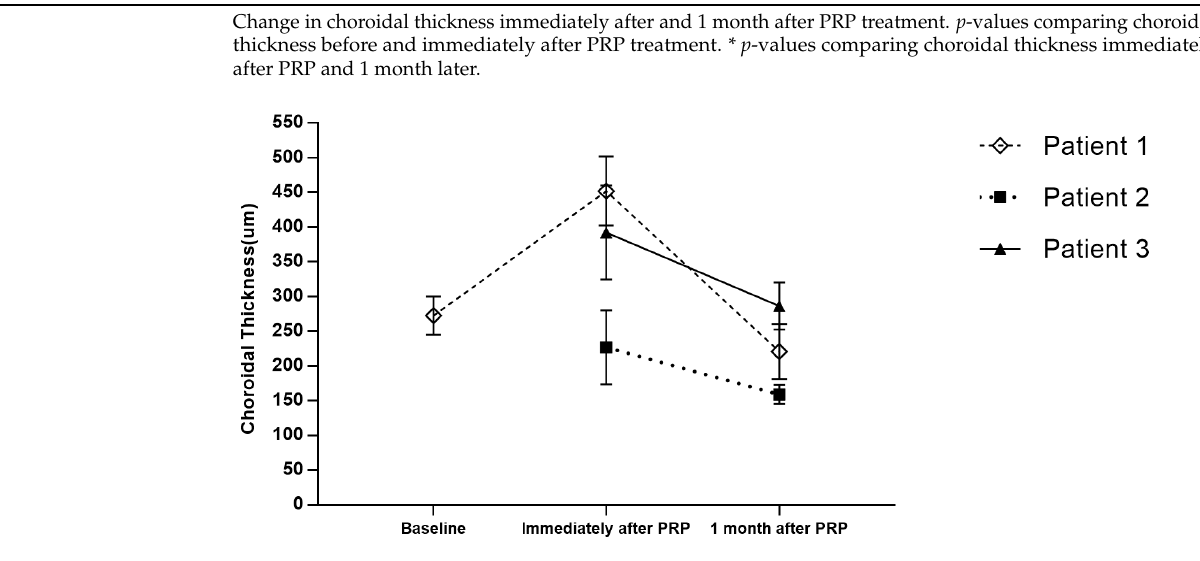
Table 1. Clinical data of patients.